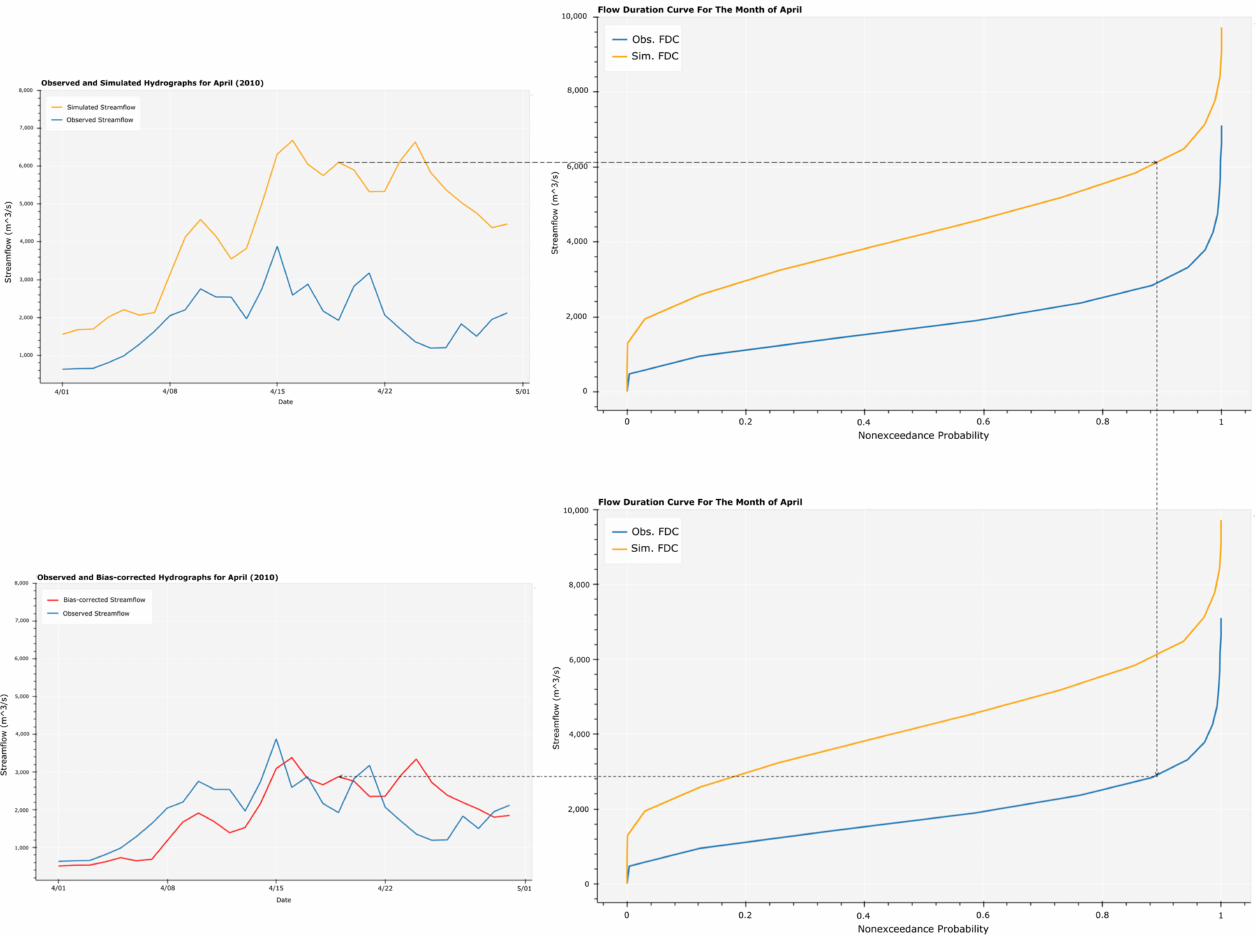
Figure 3. The bias correction methodology we developed for the GESS historic simulation, based on Farmer et al.